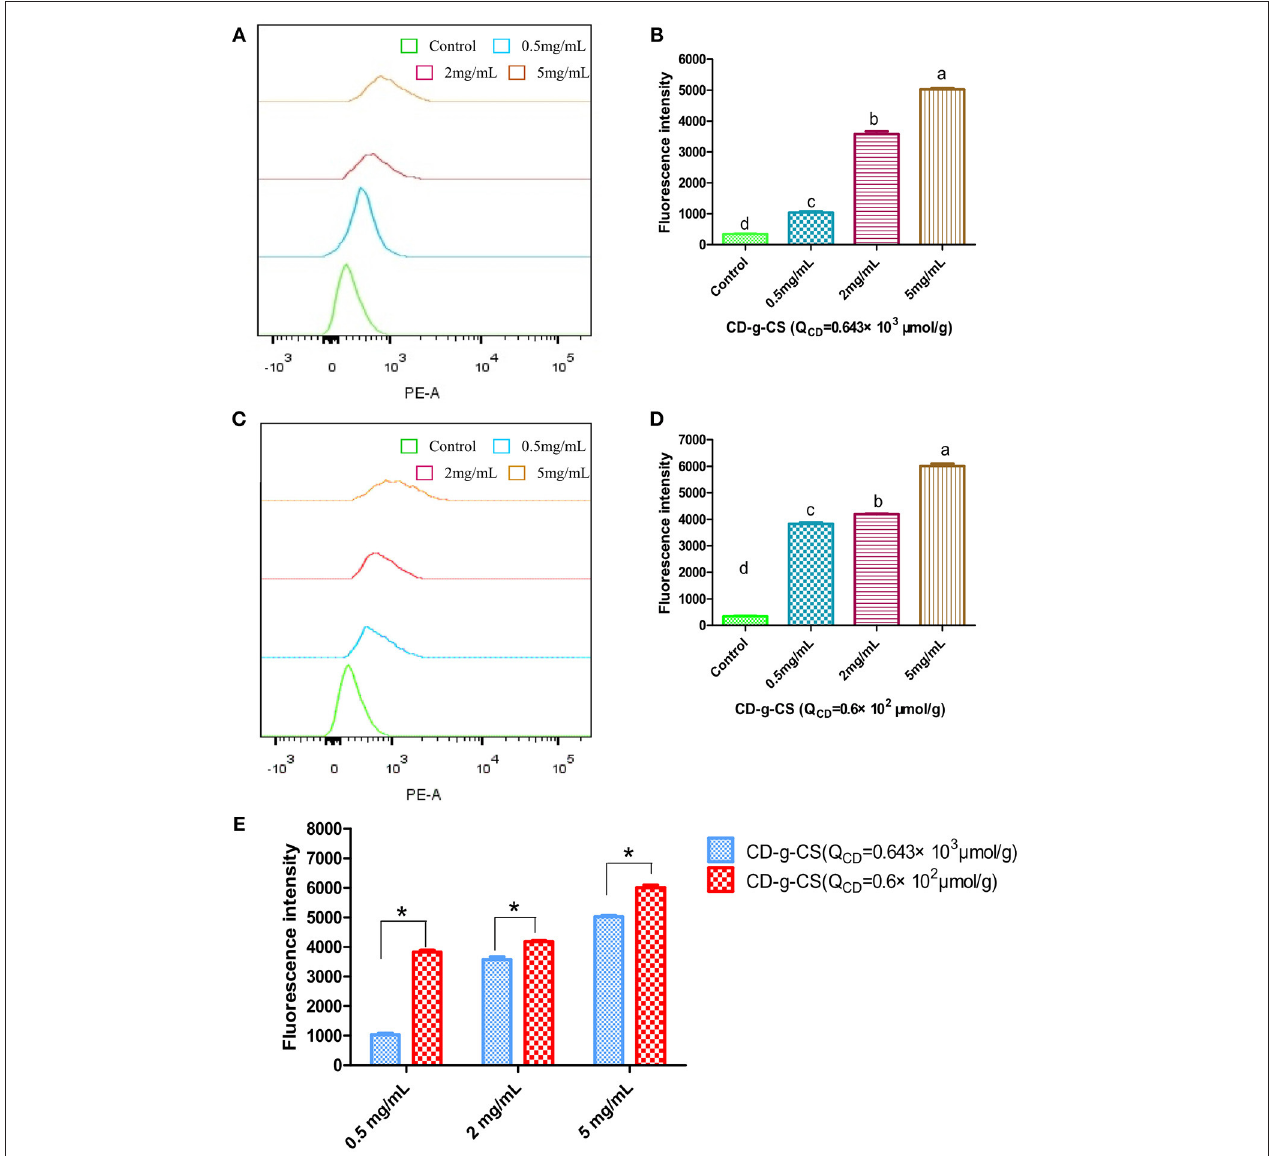
FIGURE 6 | Quantitative S. xylosus uptake of doxorubicin hydrochloride by FCS. (A,C) Flueorescence intensity measured after S. xylosus was incubated with different concentrations of CD-g-CS (Q CD = 0.643 × 10 3 µ mol/g) and CD-g-CS (Q CD = 0.6 × 10 2 µ mol/g) (0.5, 2, and 5 mg/mL) for 1h, respectively. (B,D,E) Fluorescence intensity measured at 0.5, 2, and 5 mg/mL, of CD-g-CS (Q CD = 0.643 × 10 3 µ mol/g) and CD-g-CS (Q CD = 0.6 × 10 2 µ mol/g), respectively (mean ± S.D, n = 3). Different letters indicate a significant difference within groups at p ≤ 0.05 . *Indicates a significant difference between CD-g-CS (Q CD = 0.643 × 10 3 µ mol/g) and CD-g-CS (Q CD = 0.6 × 10 2 µ mol/g) at p ≤ 0.05.